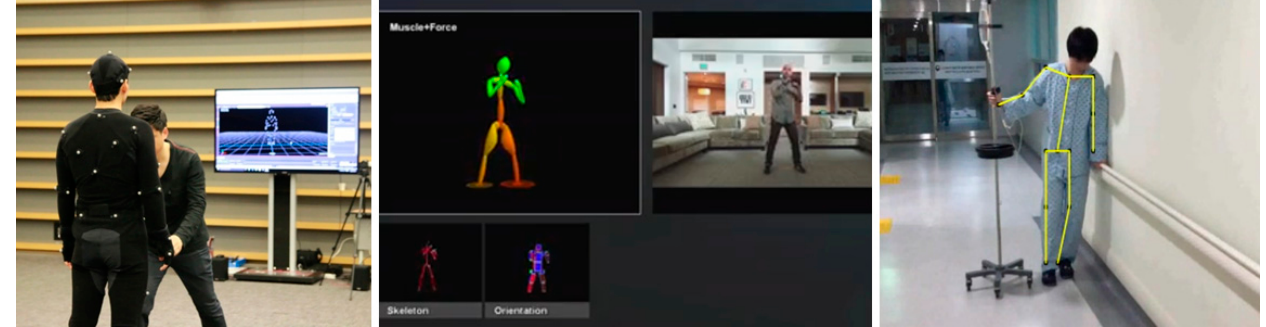
Figure 2. Various human pose estimation technology images.